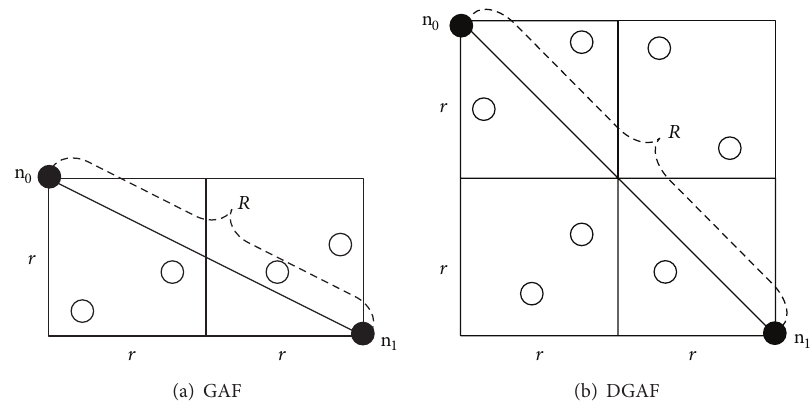
Figure 2: Example of virtual grid.